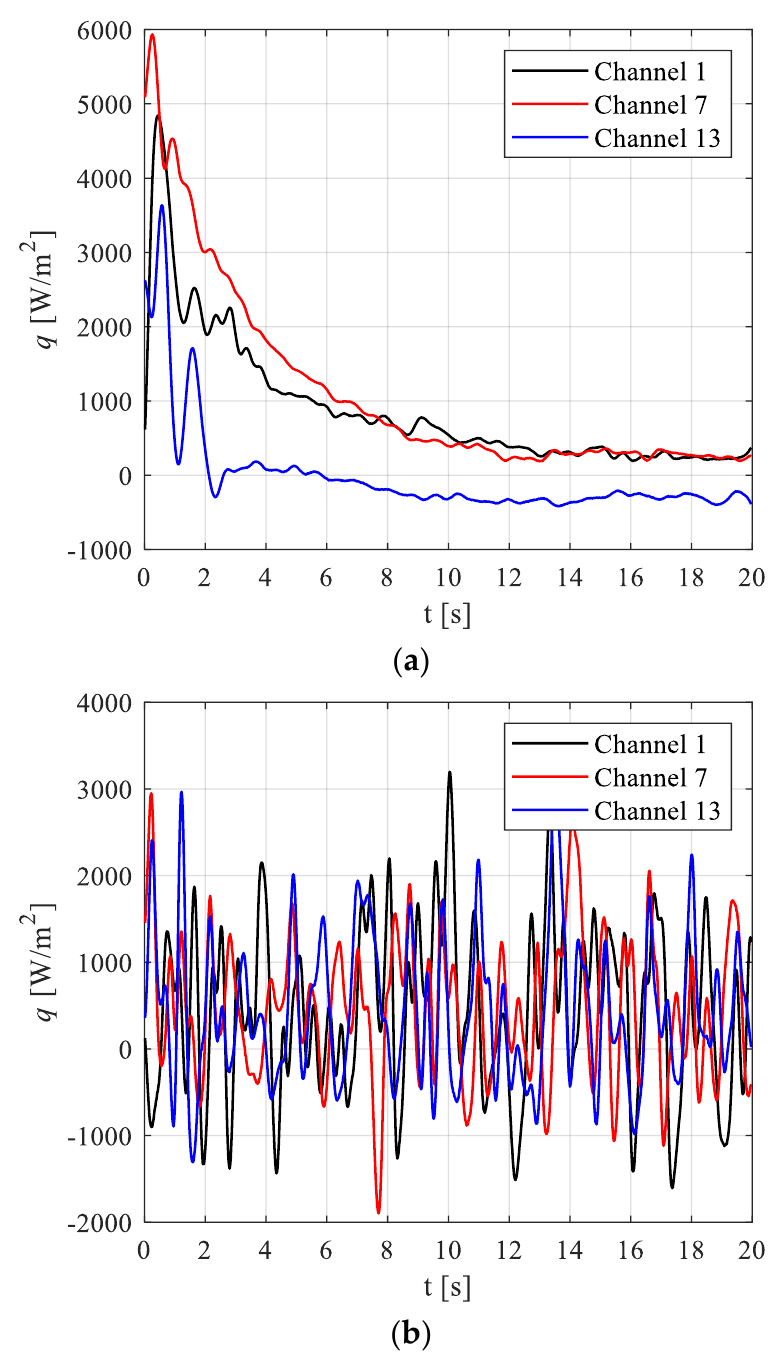
Figure 12. Local heat fluxes referred to every channel for the horizontal orientation at Q = 50 W ( a ) and for the vertical BHM at Q = 150 W ( b ).